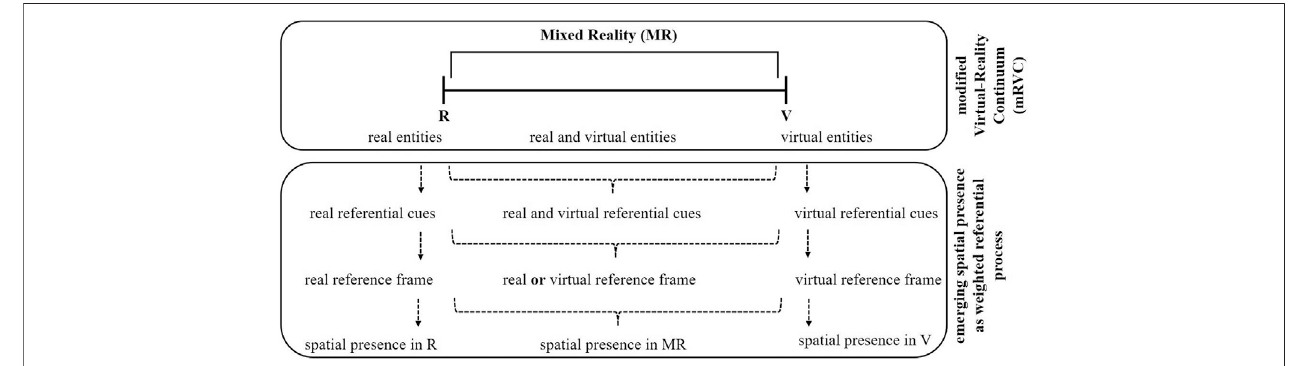
FIGURE 1 | The upper panel illustrates the modi fi ed Virtual-Reality-Continuum (mRVC). The continuum is based on Milgram and Colquhoun (1999) continuum with the addition of real and virtual entities possessing a certain degree of referential power. The bottom panel illustrates that entities can become referential cues determining, in turn, the selection of the referential frame and the emergence of presence in